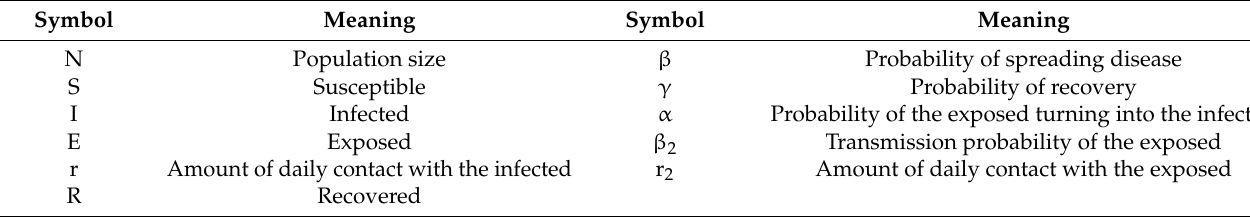
Figure 1. Structure diagram of the SEIR model. Table 1. Symbolic meaning of the SEIR model.